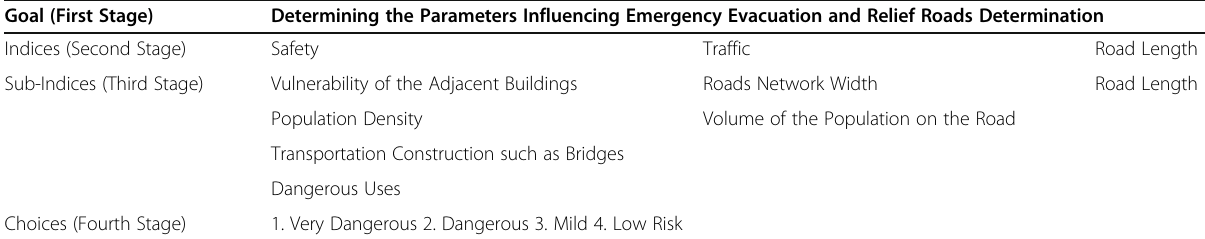
Table 3 AHP derived from experts ’ opinions to determine the effective parameters in emergency evacuation and relief paths Goal (First